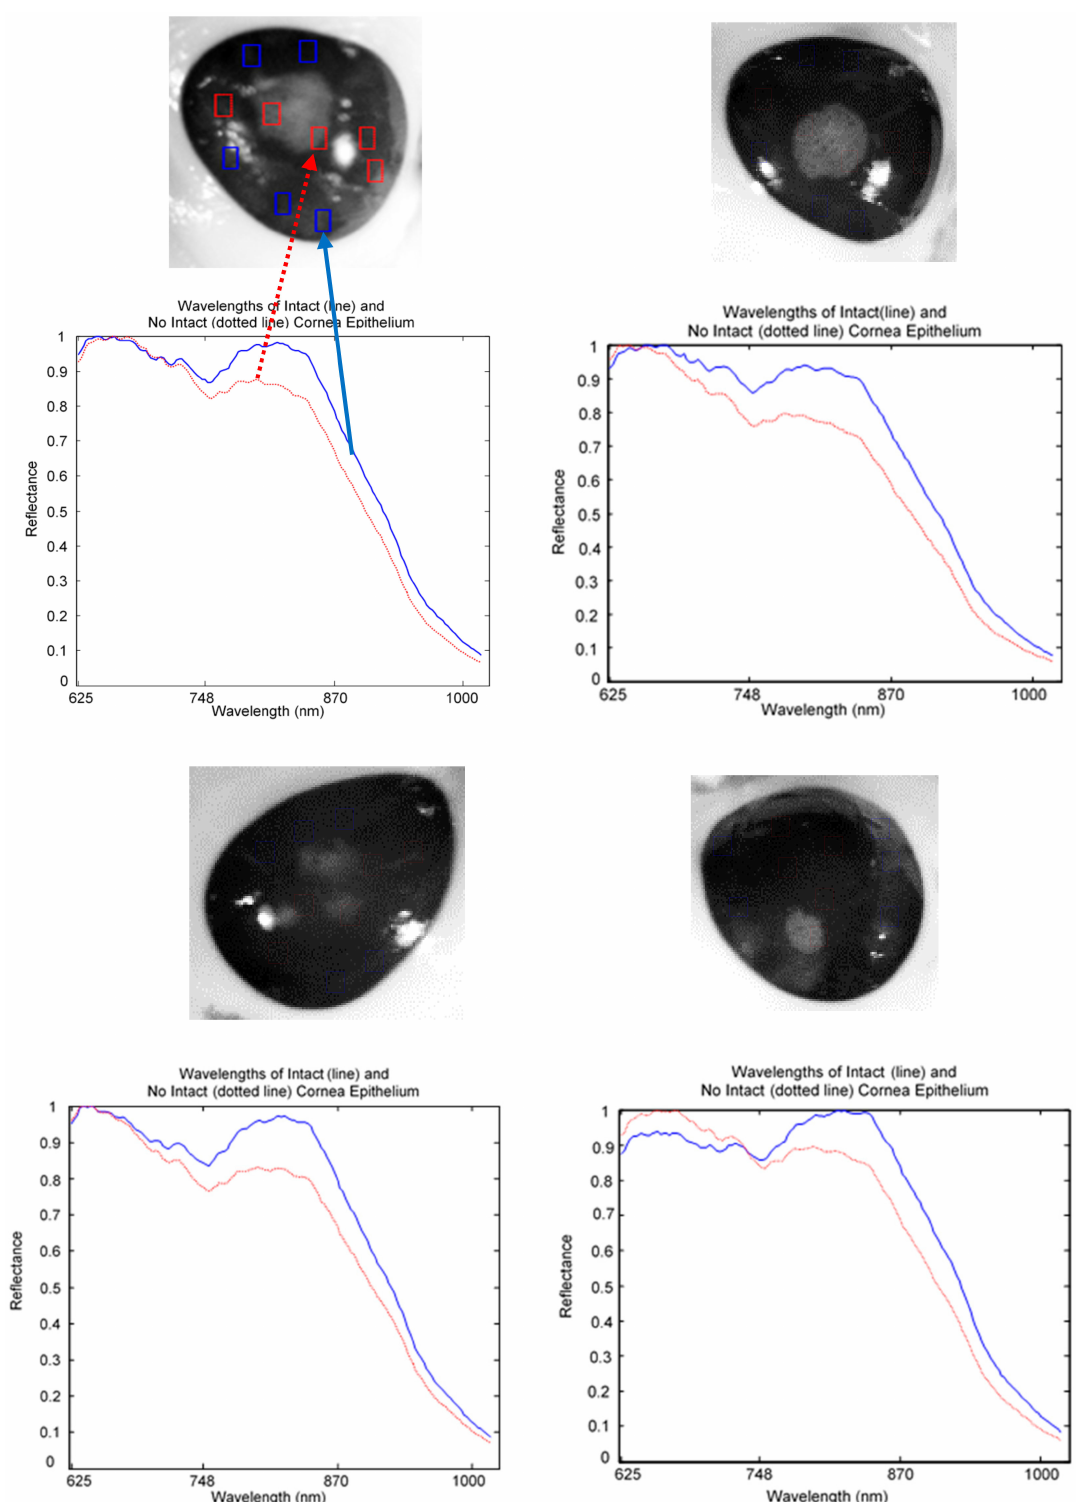
Figure 9. Reflectance signature of injured eye without